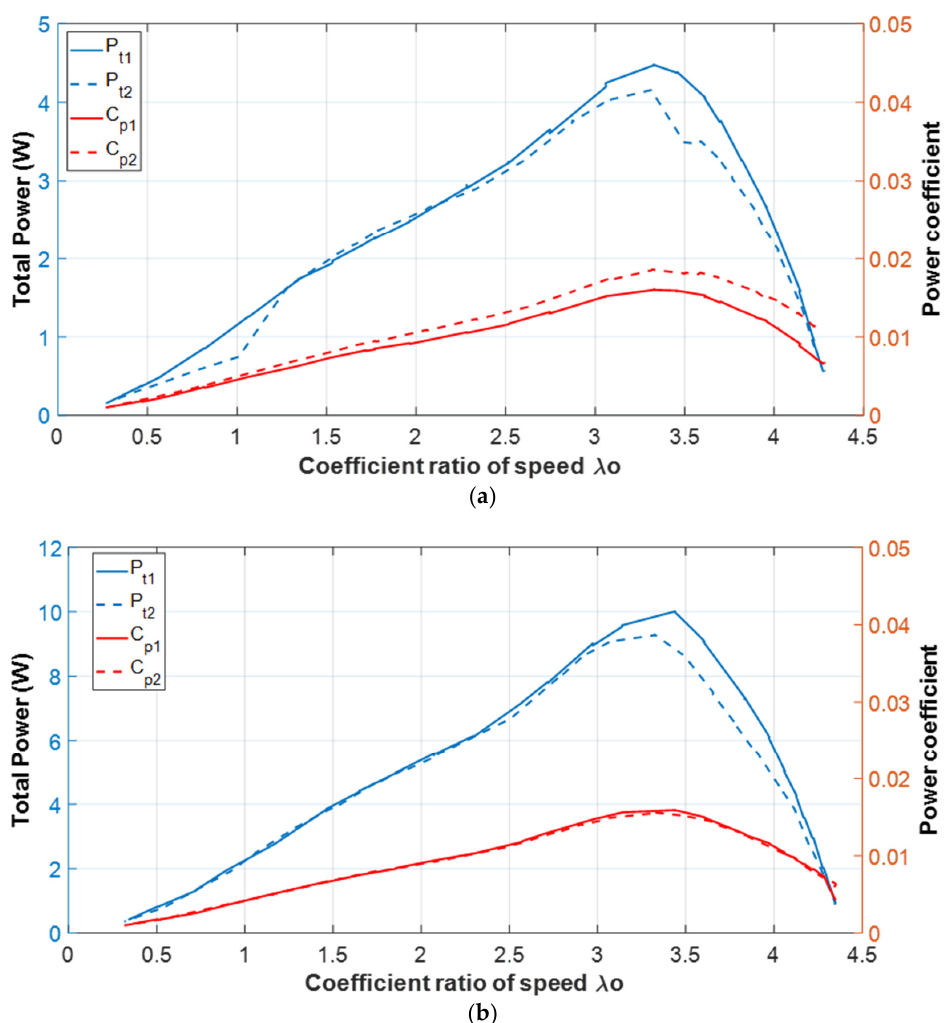
Figure 27. The total power obtained with the symmetrical load case and the asymmetrical load case in the case of wind speeds of 12 m/s ( a ) and 15 m/s ( b ). In Figure 27a, the value of the total powers obtained from the experiment with a wind speed of 12 m/s increased and reached the maximum values of 4.4 and 4.1 W as the coef- ficients of ratio speed had values of 3.3 and 3.31, respectively. In Figure 27b, in the case of a wind speed of 15 m/s, the maximum values of the total powers that can be obtained were 9 and 10.1 W. By using Equations (18)–(23), it was possible to calculate the efficiency of wind energy to electric energy conversion. Figure 27 shows a comparison of the coefficient of efficiency o in the cases of symmetrical and asymmetrical loads of a three-phase gen- erator. It can be seen from Figure 28 that the coefficient of efficiency in the case of symmet- rical load became a better value in comparison with the case of asymmetrical load. With a wind speed of 12 m/s, the coefficient of efficiency reached the highest values of 37.2% and 42.8% when the coefficients of ratio of speed (λ 0 ) were 1.55 and 3.1, respectively. In Figure 28, the maximum values of the coefficients of efficiency were 49.1% and 47.3 as λ 0 = 3.44 and λ 0 = 2.91, respectively, in the case of a wind speed of 15 m/s.